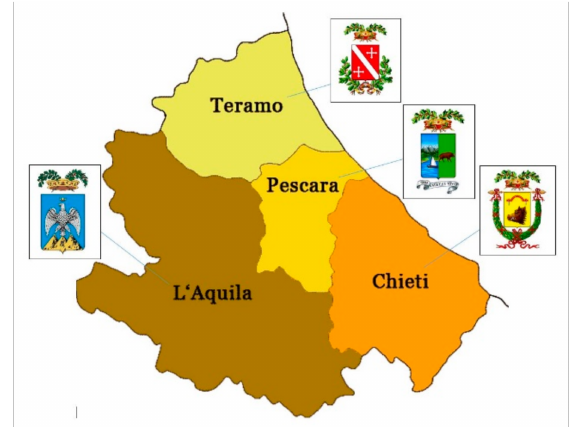
Figure 4. Subdivision by